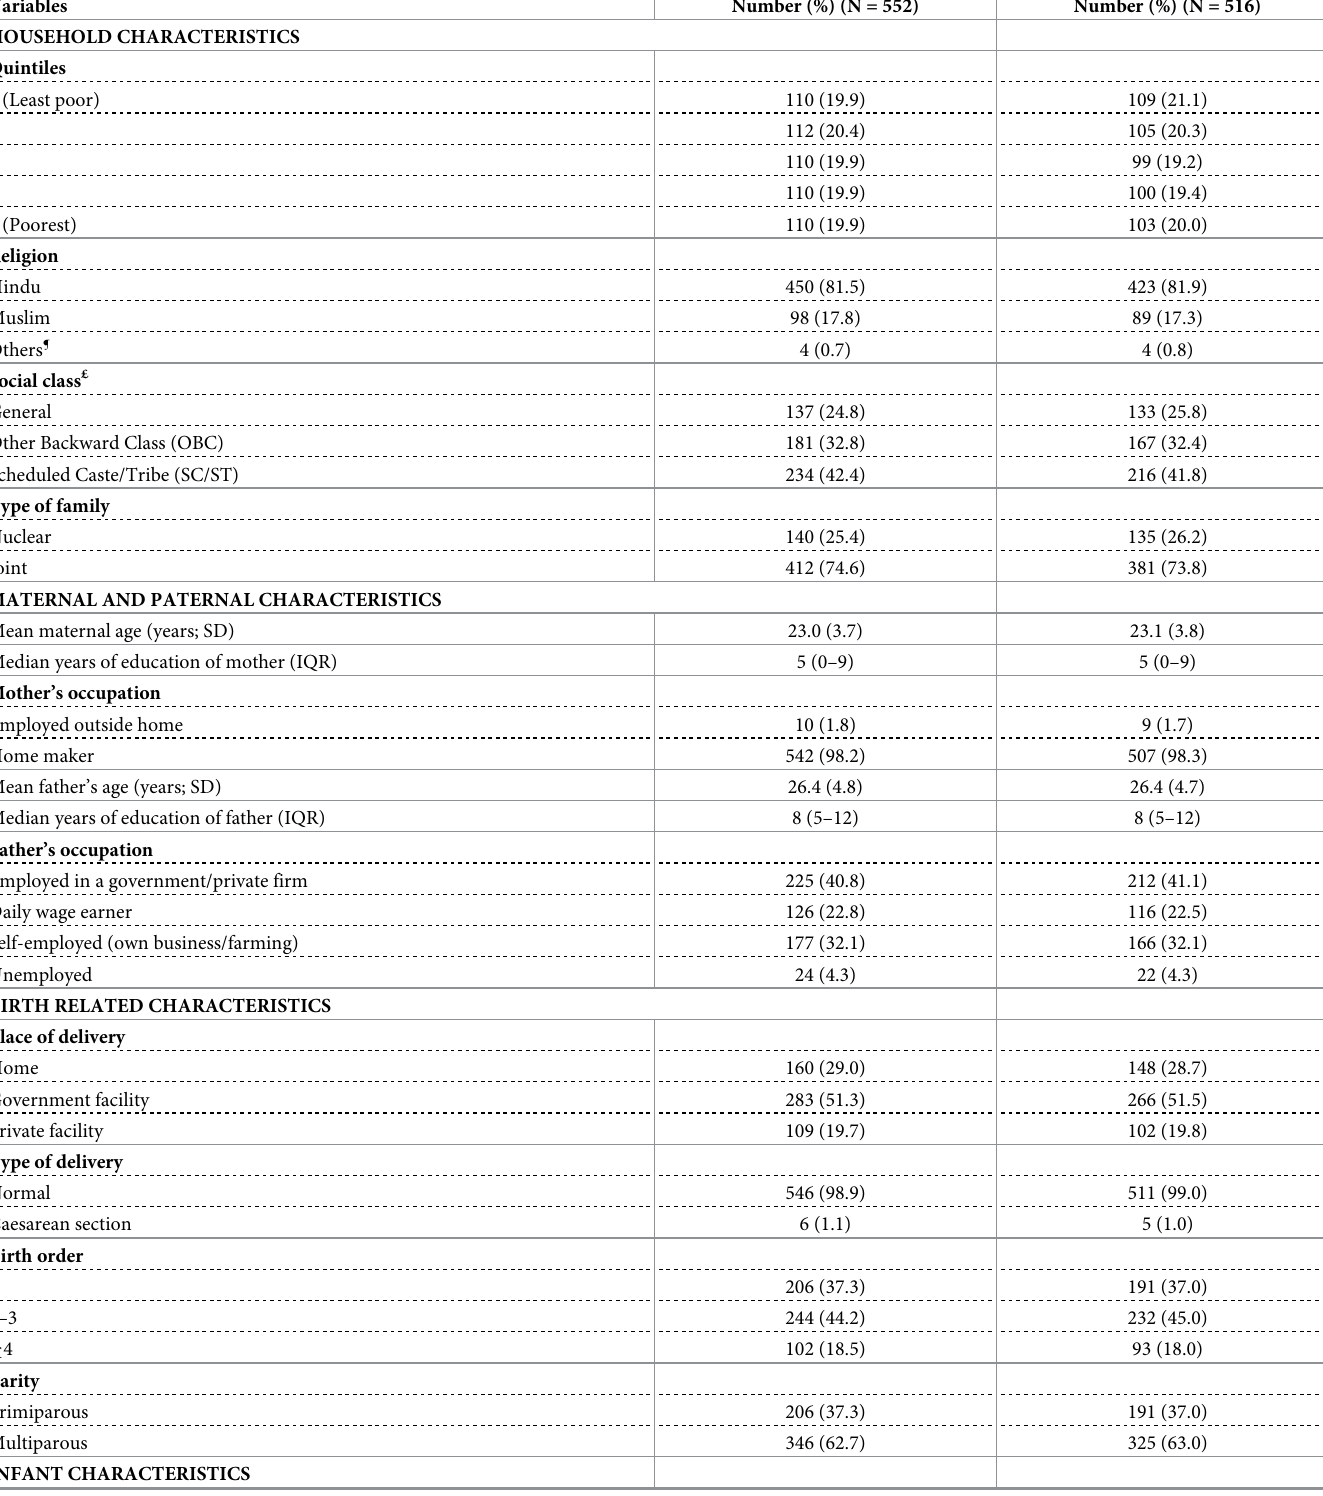
Table 1. Baseline characteristics of the primary trial population and the sample included in this secondary data